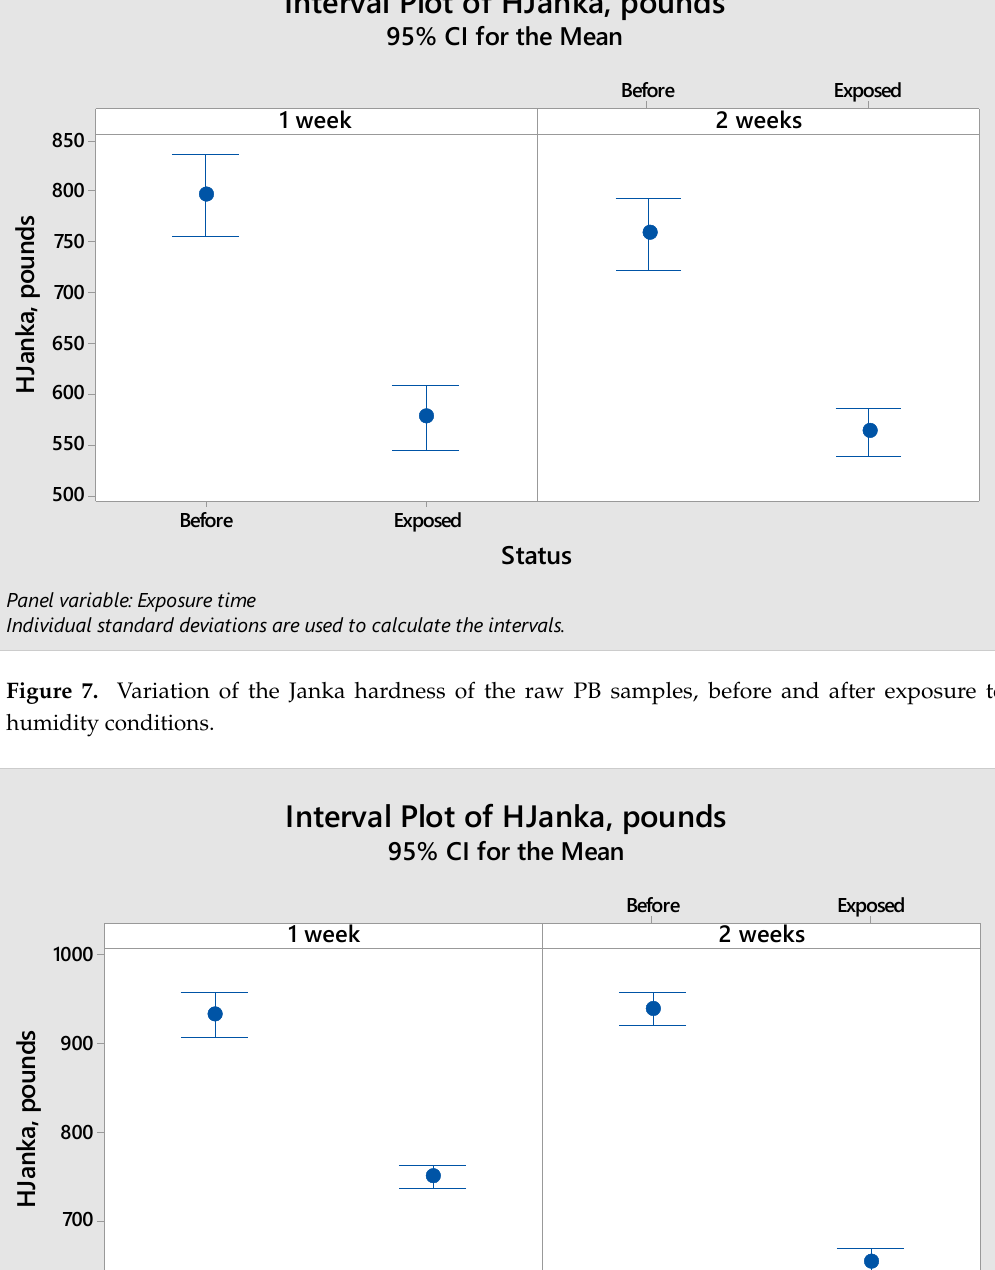
Figure 6. Variation of the mean peak-to-valley height parameter ( Rz ) of the overlaid MDF and PB samples, before and after exposure to humidity conditions.